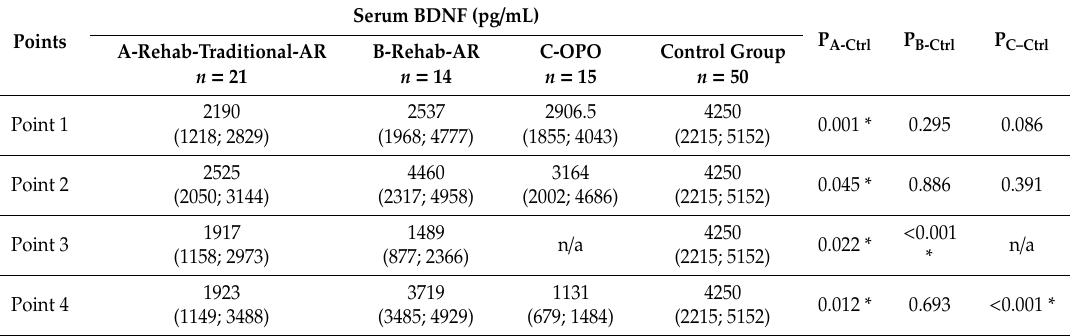
Table 2. Serum BDNF in patients with ischemic stroke and control